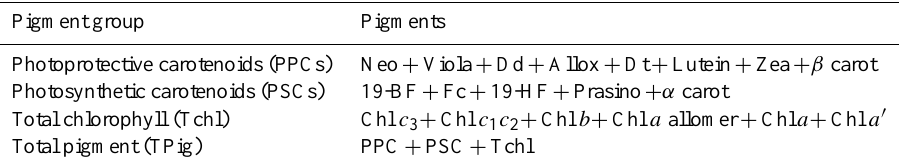
Table 2. Phytoplankton pigments used for the derivation of diagnostic pigment ratios. Pigments identified from HPLC analysis were